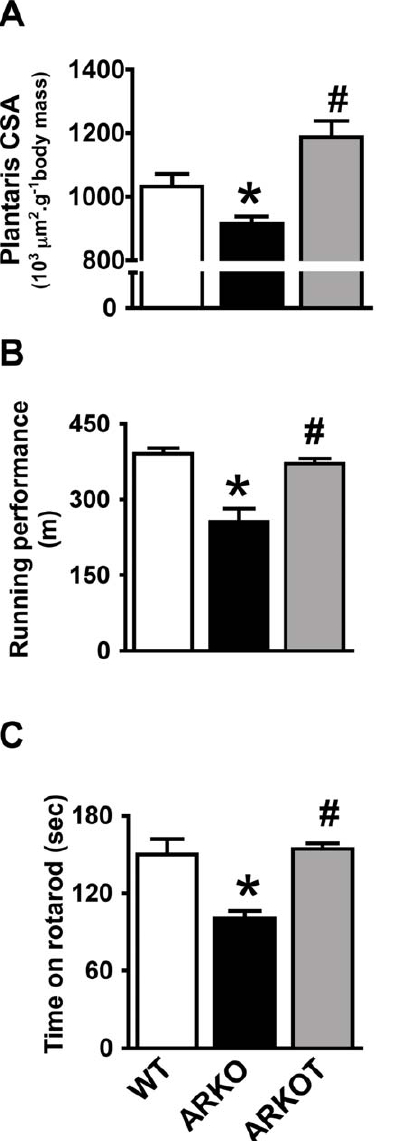
Figure 5. Skeletal muscle structure and global function . Plantaris cross-sectional area (CSA) (A), running performance (B) and time on rotarod (C) in 7 month-old wild type (WT), untrained a 2A / a 2C ARKO (ARKO) and trained a 2A / a 2C ARKO mice (ARKOT). Data are presented as mean 6 standard error from mean. *p , 0.05 vs. age-matched WT; # p , 0.05 vs. age-matched ARKO.